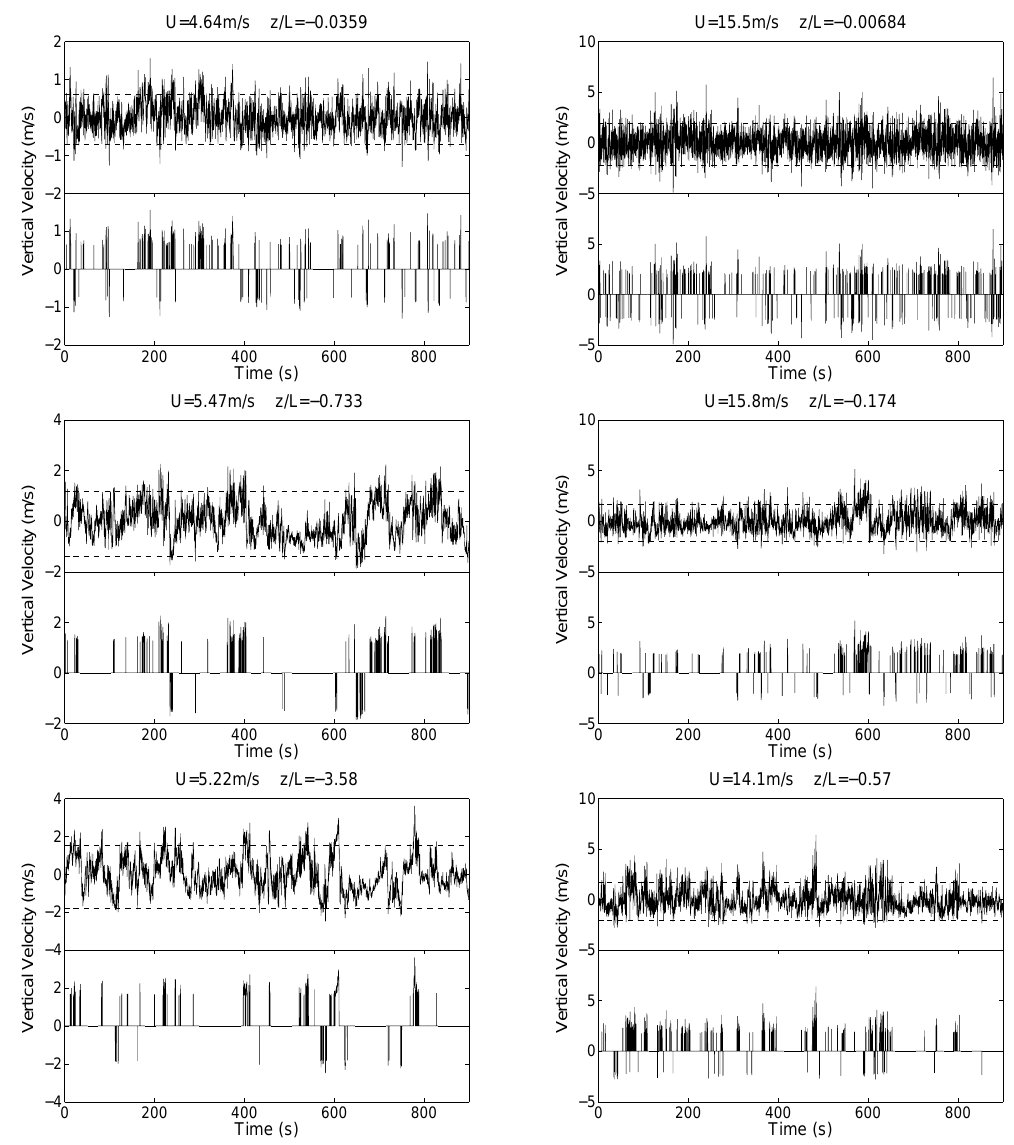
Fig. 3. Examples of extraction of extreme vertical velocity fluctuations at different stability parameters and mean velocities. The top one in each panel is the original time series and the bottom one is the corresponding extracted extreme fluctuations. Thresholds are denoted by dashed lines in each panel.